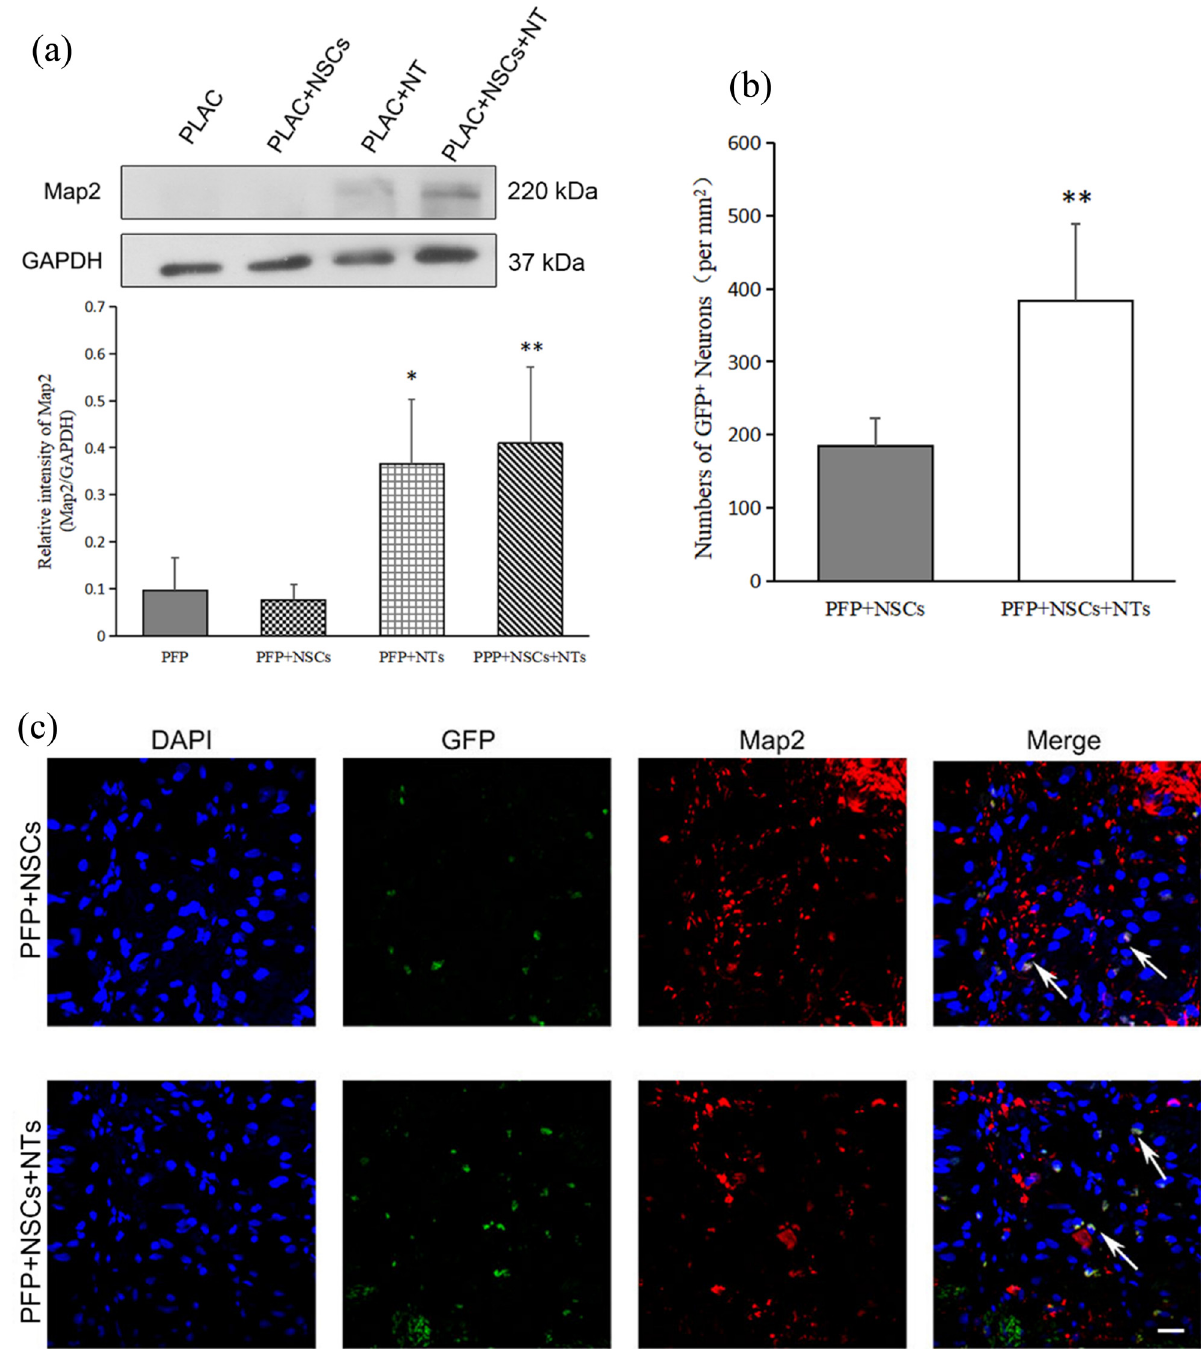
Figure 4: PFP sca ff old loaded neurotrophic factors induced NSCs to di ff erentiate into mature neurons on day 56 after transplantation. ( a ) The Map2 ( a marker of mature neurons ) levels in ischemic penumbra were tested by Western Blot ( * p < 0.05, ** p < 0.01 vs PFP group, n = 3 ) . ( b and c ) Tissue samples were immunostained with Map2 antibody and nuclei were labeled by DAPI. The images were captured by a Zeiss LSM 710 confocal microscope with a 20 × objective ( Red, Map2; Green, GFP; Blue, DAPI ) . Fluorescent staining with GFP and Map2 revealed that the donor NSCs di ff erentiated into mature neurons. Scale bar = 20 µm. The results are shown as the mean value ± SD ( ** p < 0.01 n = 3 )